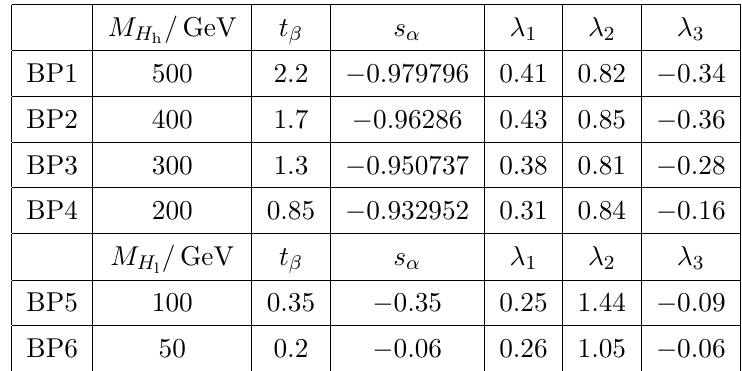
Table 5. HSESM benchmark points compiled from ref. [94]. In the upper table typical scenarios are depicted with a heavy additional scalar Higgs boson. In the lower table inverted scenarios are listed with H h identi(cid:12)ed as the SM Higgs boson and mass M H self-couplings (cid:21) i depend on the other parameters and their real parts are given for